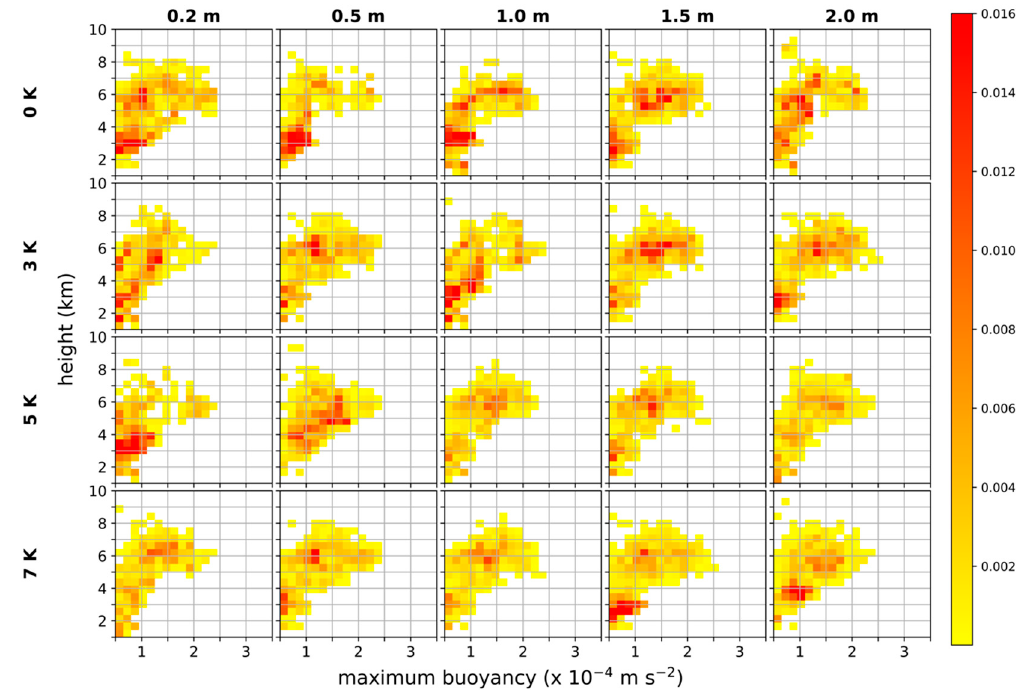
Figure 12. CFADs of maximum buoyancy along forward-integrated trajectory parcels located within an updraft at t = 120 min for each simulation. Maximum buoyancy is determined by examining the parcel’s history over the previous 50 min. Only parcels that achieve positive buoyancy are shown.